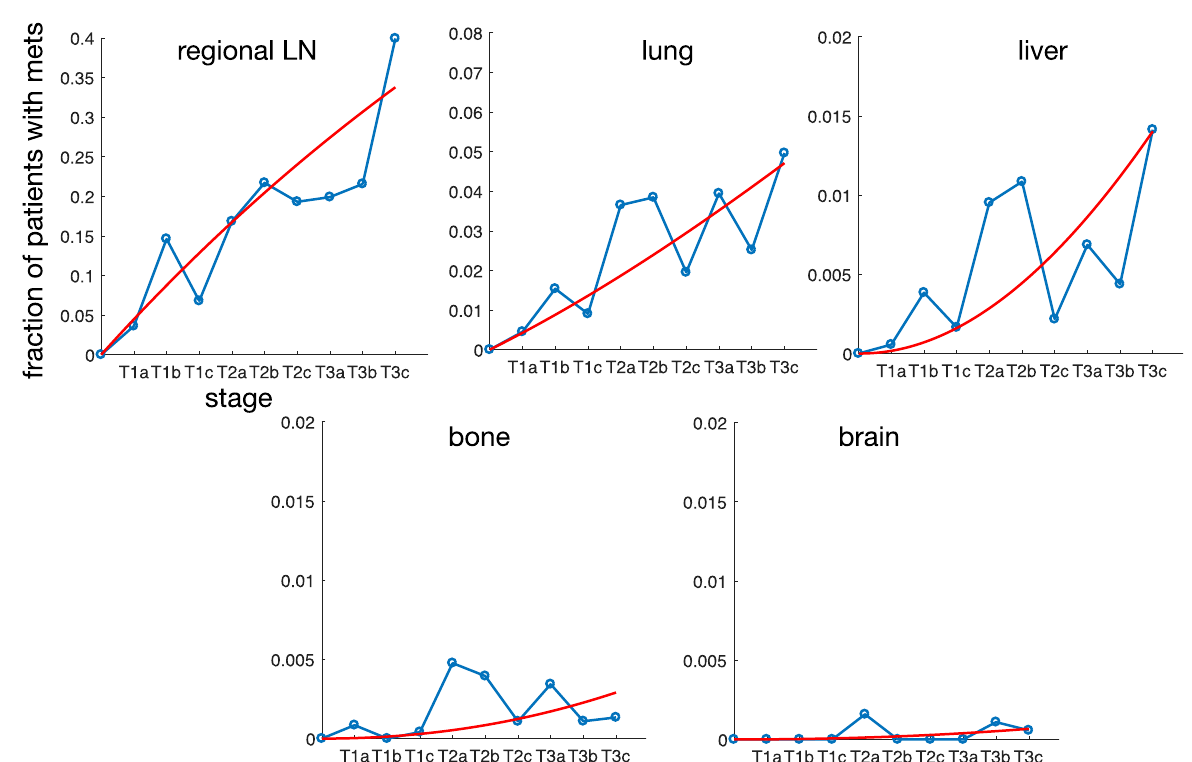
Fig 4. The data and model predictions for metastatic spread to regional lymph nodes and distant sites for primary ovarian cancer. Each panel corresponds to a site/organ and shows the probability of finding a metastases at the site as a function of the primary tumour stage. The parameters of the model are given in Table 2.